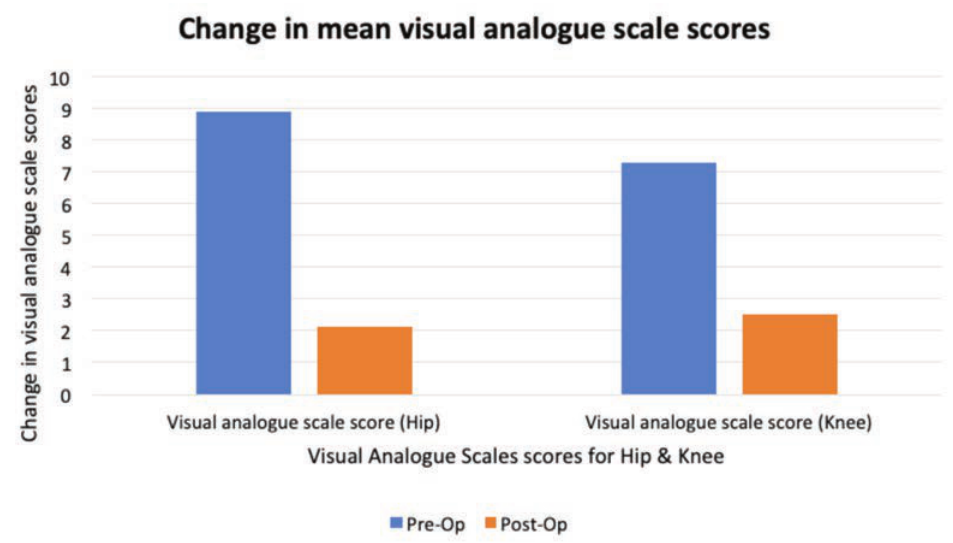
Mean visual analogue scale scores pre- and Fig. 2: